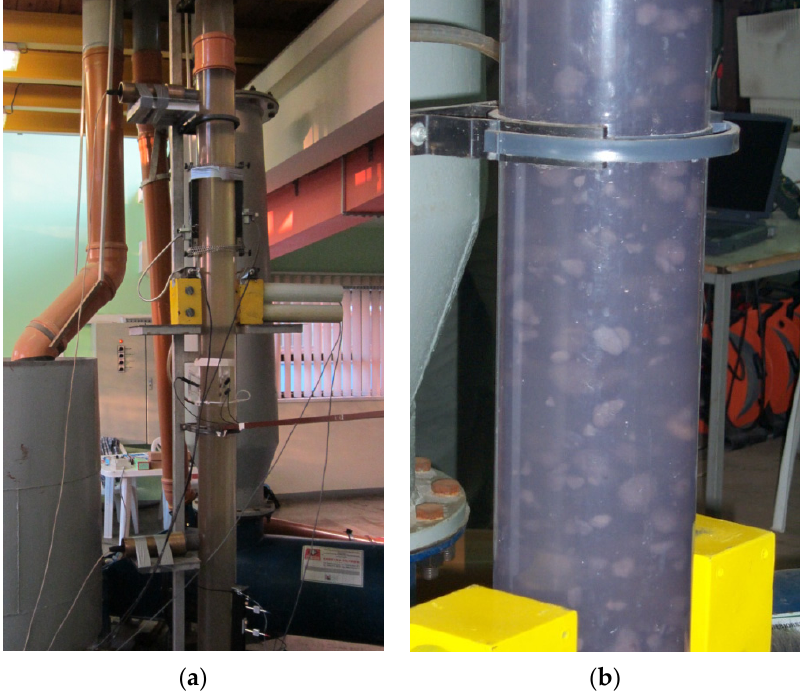
Figure 4. Fragments of the installation for testing liquid–solid particles flow in a vertical pipe: ( a ) view of the measuring part of the laboratory stand; ( b ) pipe with the water–solids mixture [36].